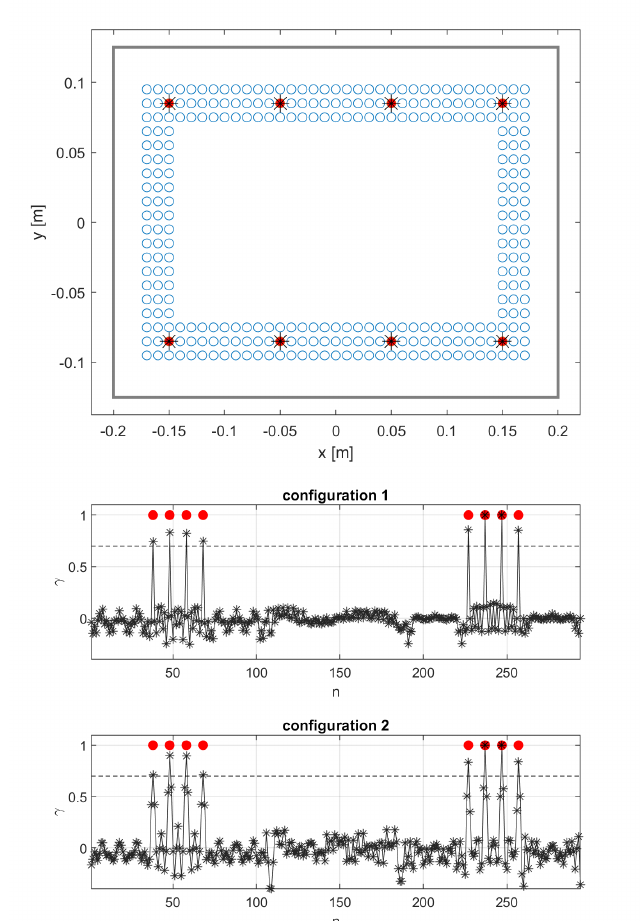
Figure 5. Bars’ detection ( top ) and reconstructed γ ( n ) for the two measurement configurations ( bottom ). Red circles represent actual bars. Black stars represent detected bars. A threshold of 0.7 has been applied.